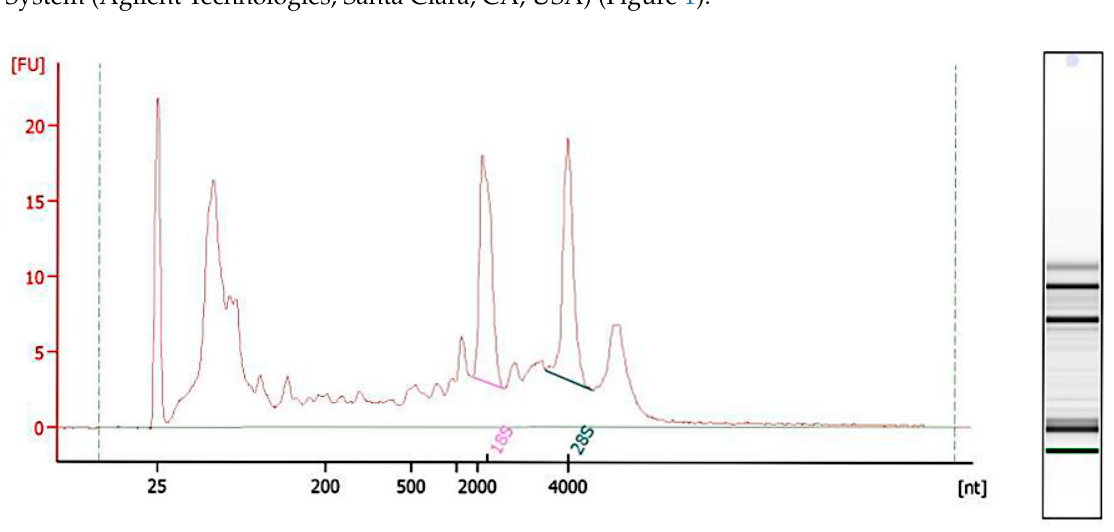
Figure 1. RNA integrity analyzes of giant panda sperm showed 28S and 18S.